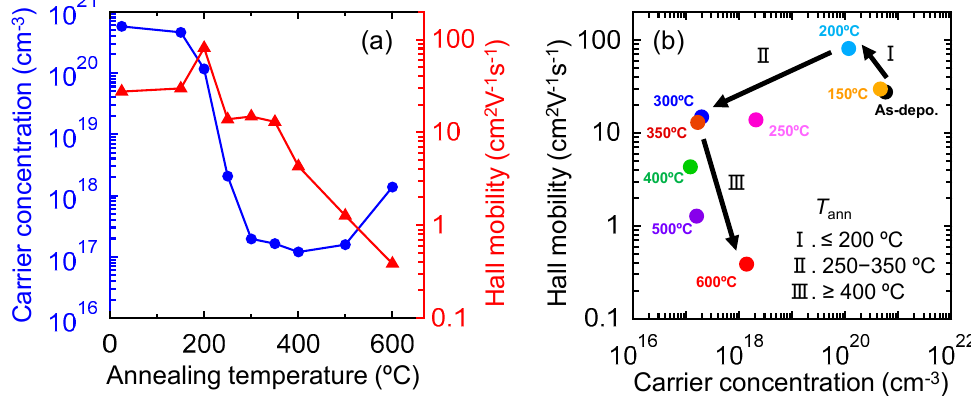
Figure 1. ( a ) N e and μ H of In 2 O 3 :H films as a function of T ann . ( b ) Relationship between μ H and N e for In 2 O 3 :H films with various T ann values.